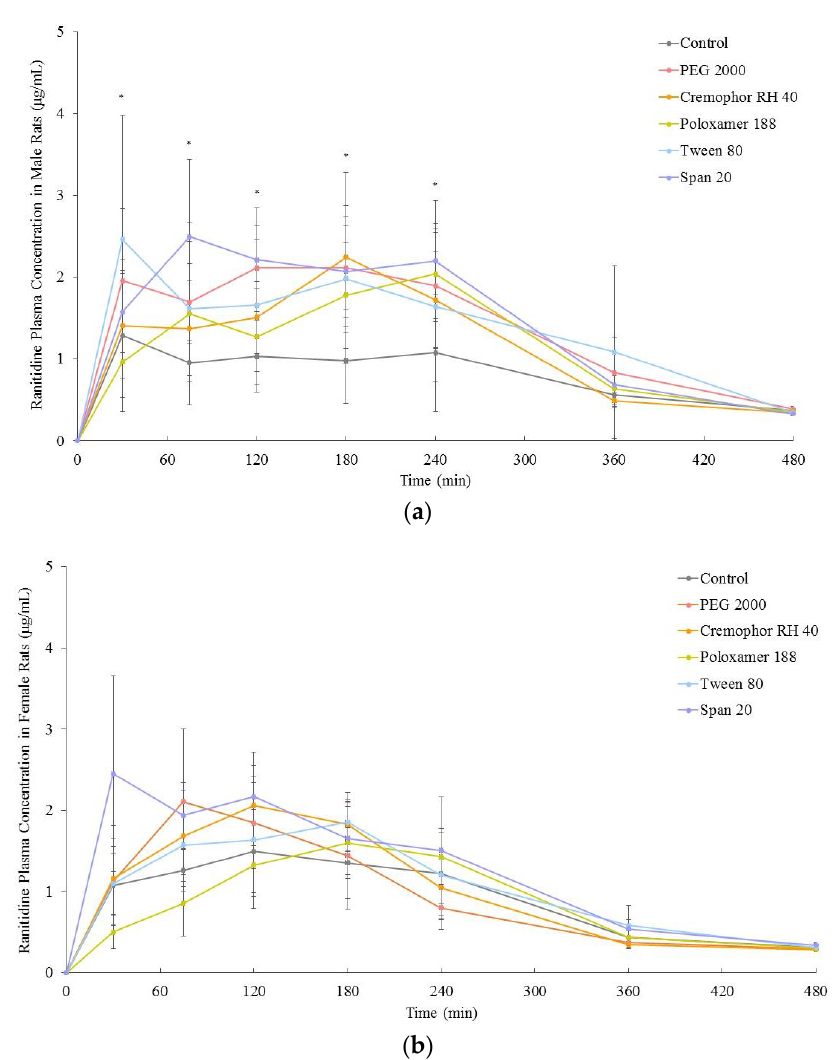
Figure 3. In vivo mean plasma concentration-time curve of ranitidine in the absence (control) or presence of excipients in male (a) and female (b) rats ( n = 6).